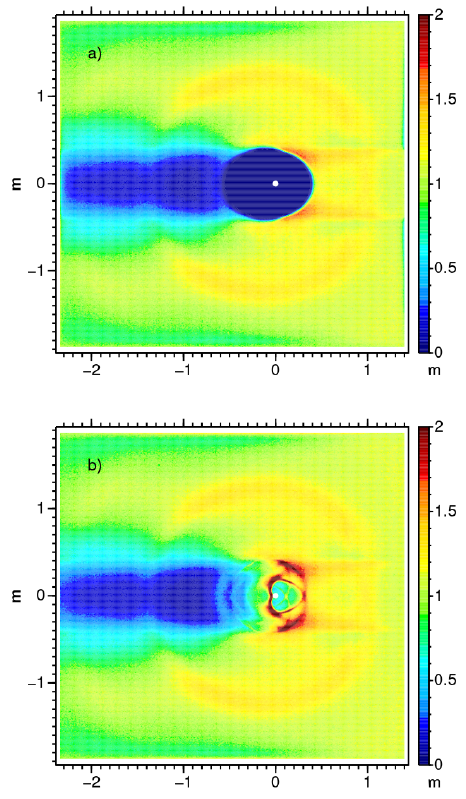
Figure 6. Run Bz: same as Fig. 2, but with B z = 30 000nT.